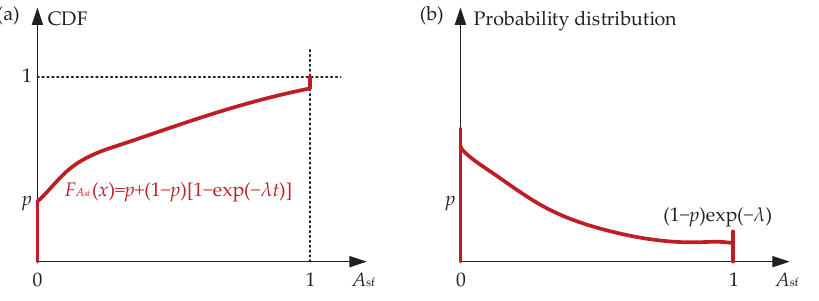
Figure 3. Illustration of the probability distribution of A sf ( t )